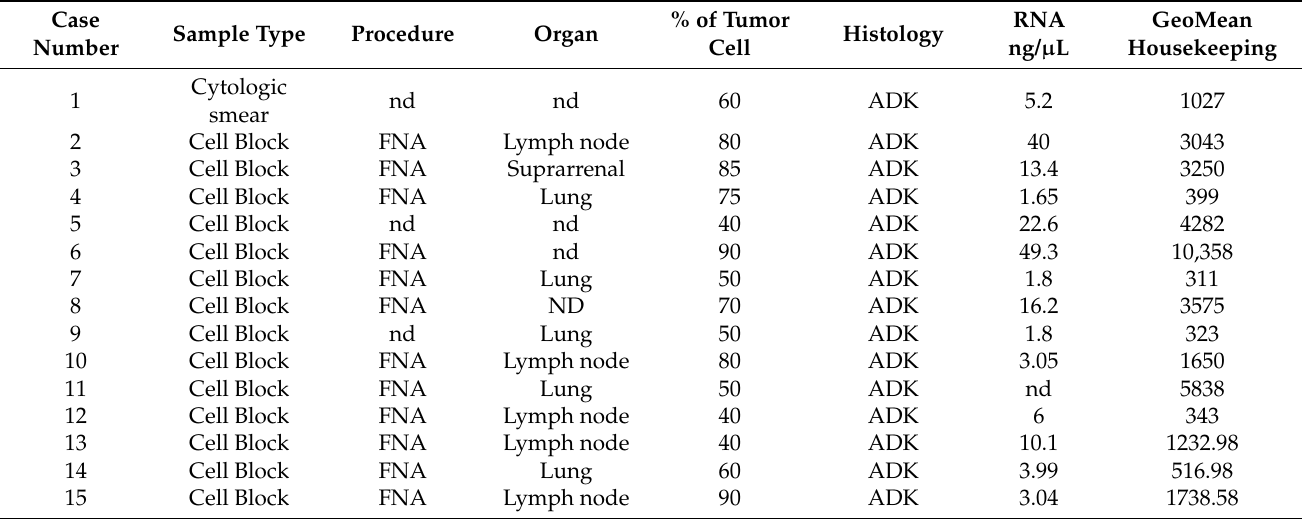
Table 3. Characteristics of the valid cytological samples included in the study.